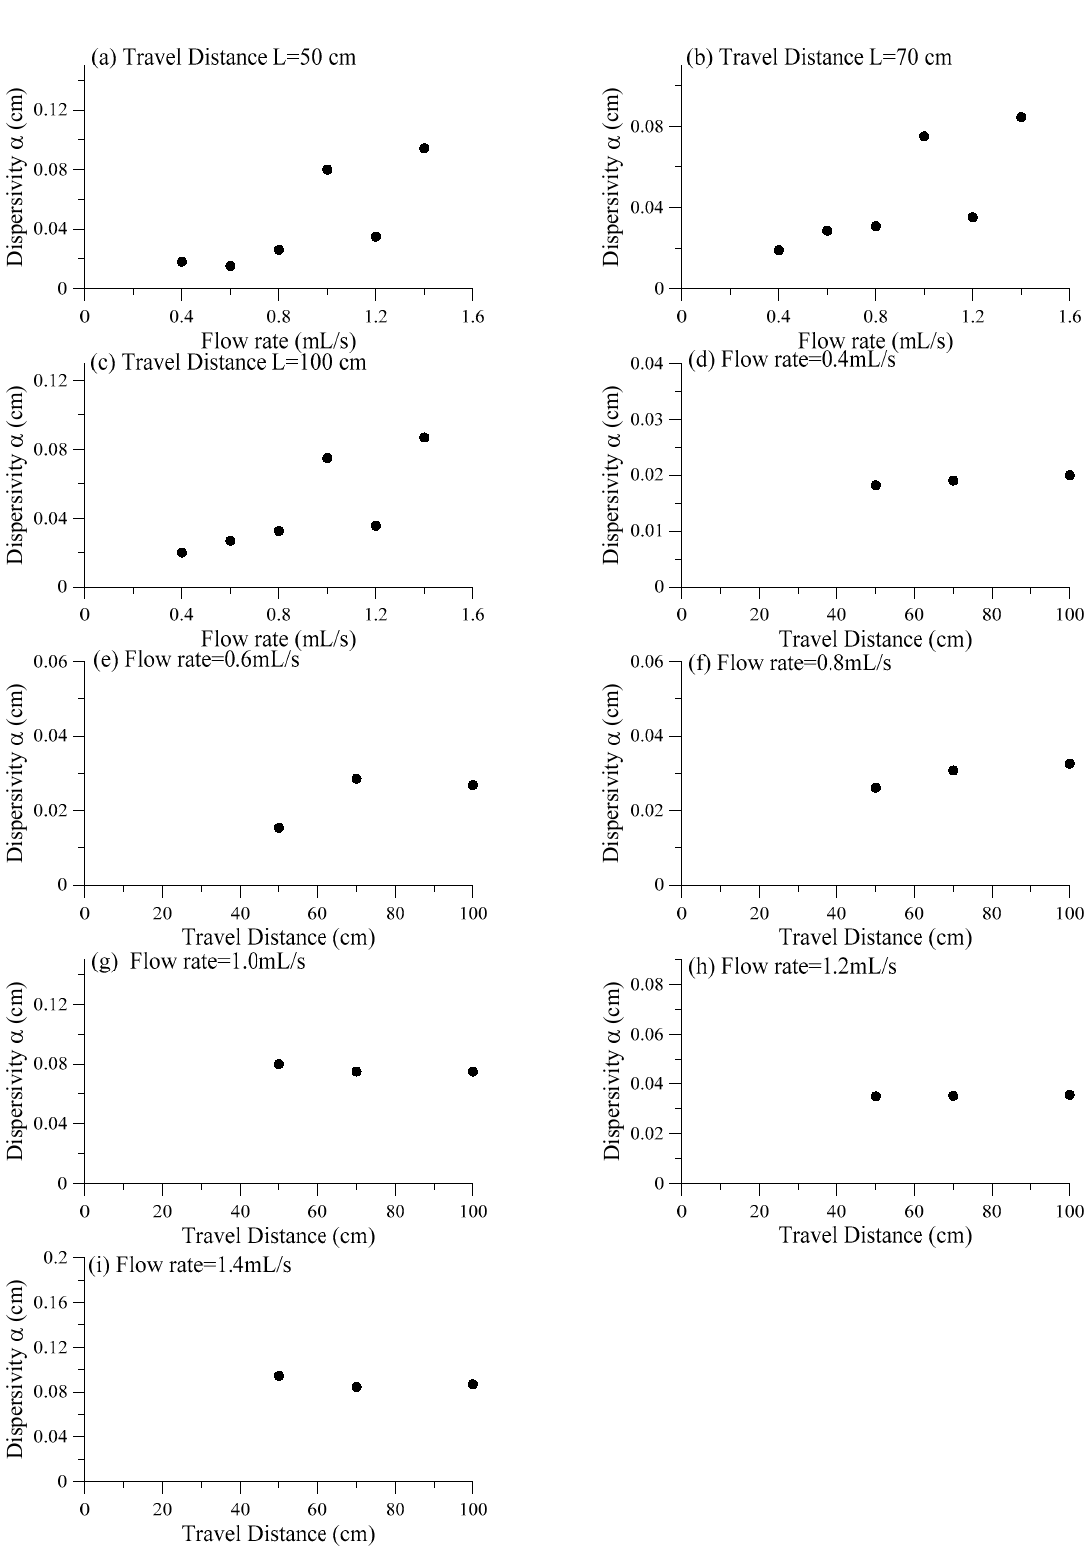
Figure 5. Dispersivity in the tt-fADE model changes with the travel distance and flow rate.